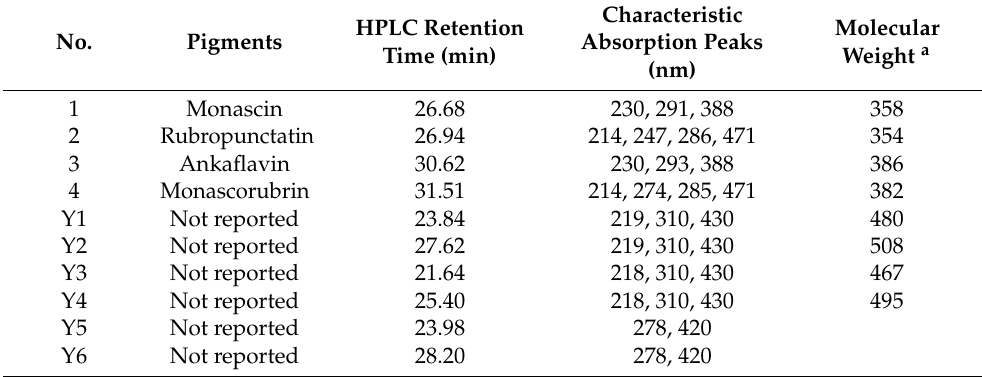
Table 1. Individual Monascus pigments detected by